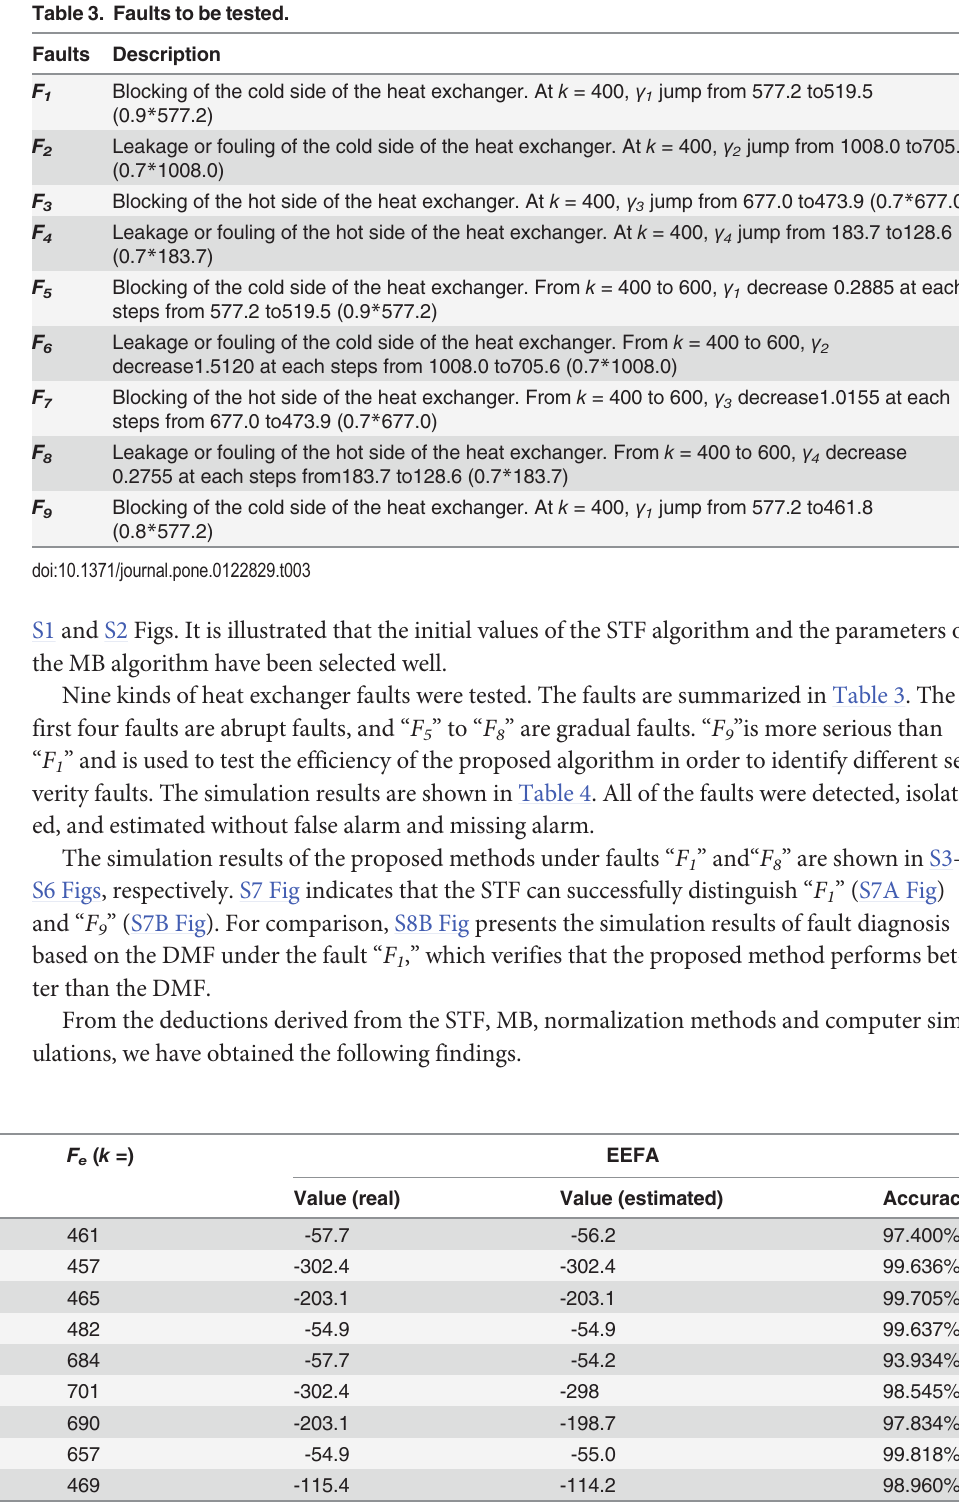
Table 3. Faults to be tested. Faults Description